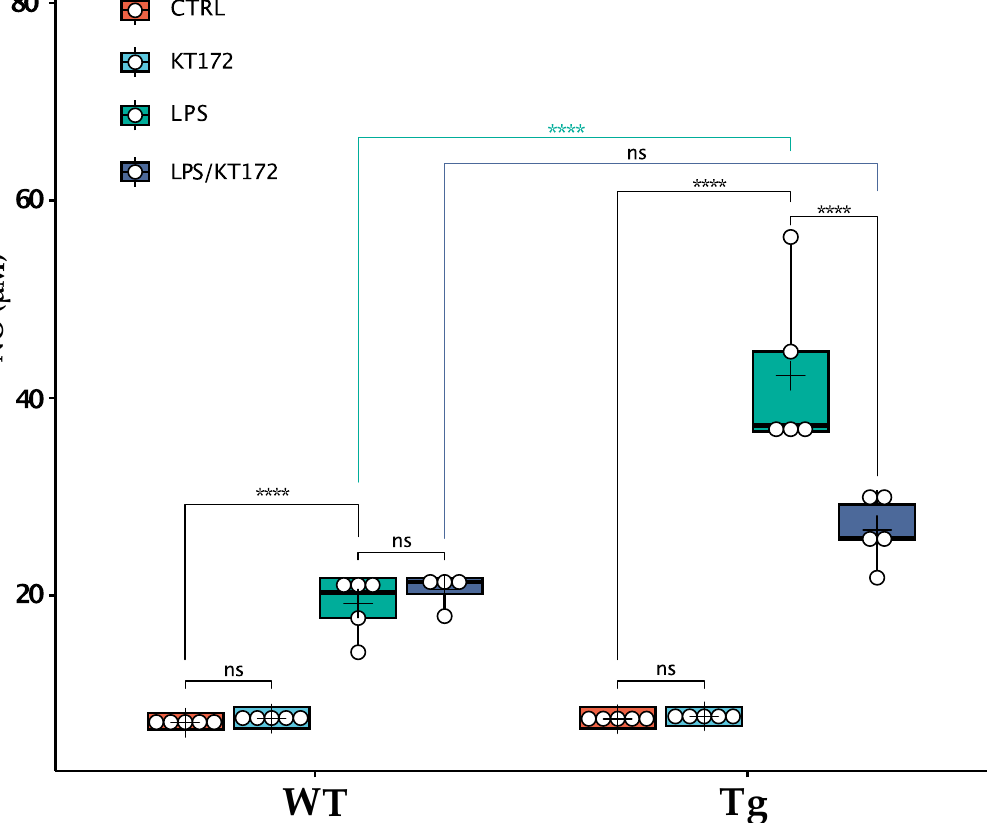
Figure 4. Release of NO by wild-type (WT) and Tg2576 (Tg) microglia following different treatments. WT and Tg2576 microglia were left untreated (CTRL) or were treated with 0.1 μ M KT172 (KT172), 100 ng/mL LPS (LPS), or with their combination (LPS/KT172) for 20 h. After each treatment, NO content was measured in cell supernatants using a Griess assay. Horizontal line and + within the rectangle (boxplot) represent the median and the mean, respectively, of the values of five independent experiments (white circles). A two-way ANOVA was used to compare differences between different treatments in microglia of different genotypes. Significance is shown as a p value, calculated using a post hoc Tukey’s test. **** p < 0.0001; ns: not